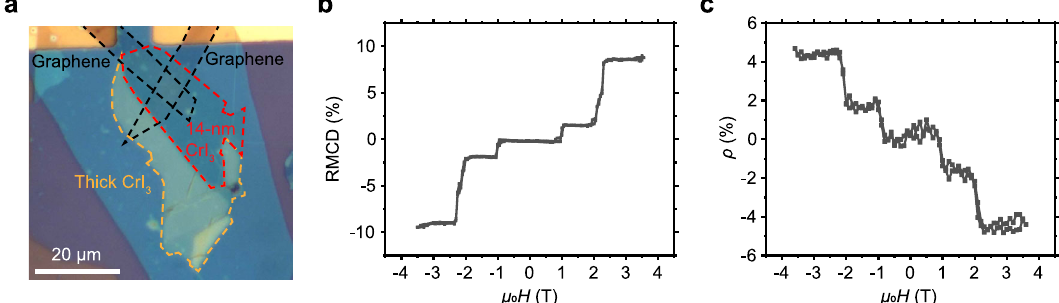
Fig. 4 The multilayer CrI 3 light helicity detector D2. a Optical image of the 14 nm thick CrI 3 (demarcated by the red dashed lines) light helicity detector D2 with few-layer graphene contacts (demarcated by the black dashed lines). The yellow dashed lines demarcate the thick CrI 3 , which was not illuminated by the excitation light in the measurements. The device is encapsulated by h BN fl akes. The re fl ective magnetic circular dichroism (RMCD) signals ( b ) and photoresponsivity polarization ρ ( c ) versus μ 0 H relations of the device. Both RMCD and ρ show fi ve plateaus when μ 0 H sweeps between − 3.5 and + 3.5 T, and equal 0 at μ 0 H = 0 T, corresponding to the AFM ground state. RMCD signals and ρ values saturate at ~±10 and ±4.5%, respectively, when | μ 0 H | > 2.2 T, corresponding to the fully spin-polarized